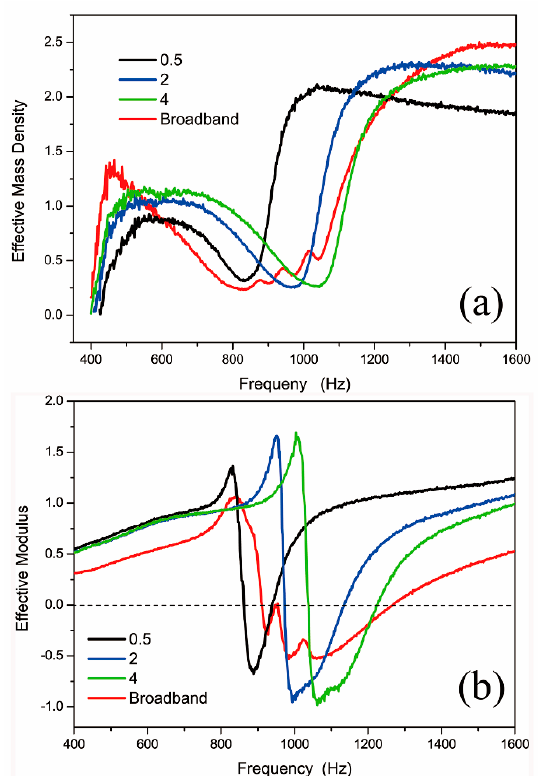
Figure 8. The effective parameters of broadband AMM: ( a ) effective mass density and ( b ) effective Figure 8. The e ff ective parameters of broadband AMM: ( a ) e ff ective mass density and ( b ) e ff ective modulus. modulus.